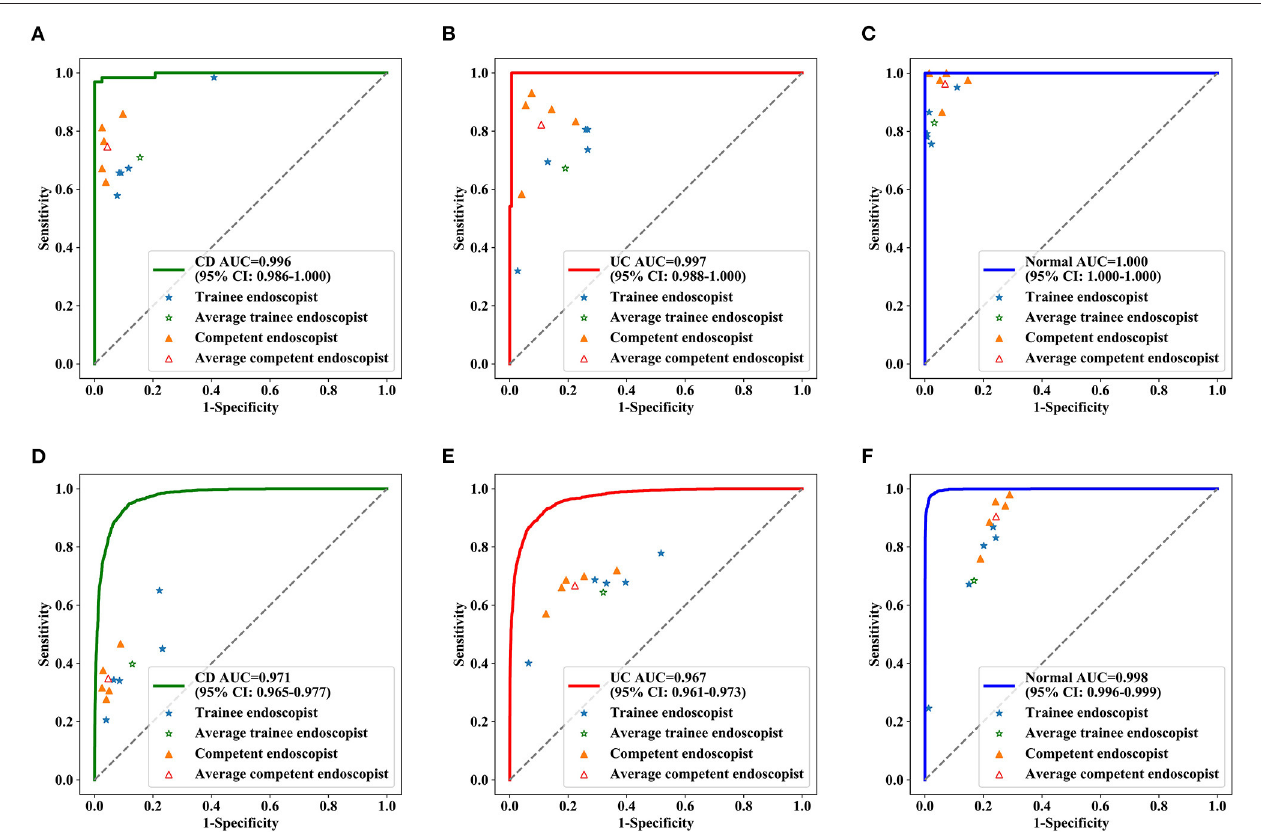
FIGURE 4 | Diagnostic performance of deep model and endoscopists in the test dataset. ROC curve for CD (A) , UC (B) and normal (C) at the patient level, ROC curve for CD (D) , UC (E) , and normal (F) at lesions level. The blue stars indicate the diagnostic sensitivities and specificities of the trainee endoscopists, the green star indicates the pooled sensitivities and specificities of all trainee endoscopists, the yellow triangles indicate the diagnostic sensitivities and specificities of the competent endoscopists, and the red triangle indicates the pooled sensitivities and specificities of all competent endoscopists. AUC, the area under the receiver operating characteristic curve; ROC, receiver operating characteristic.